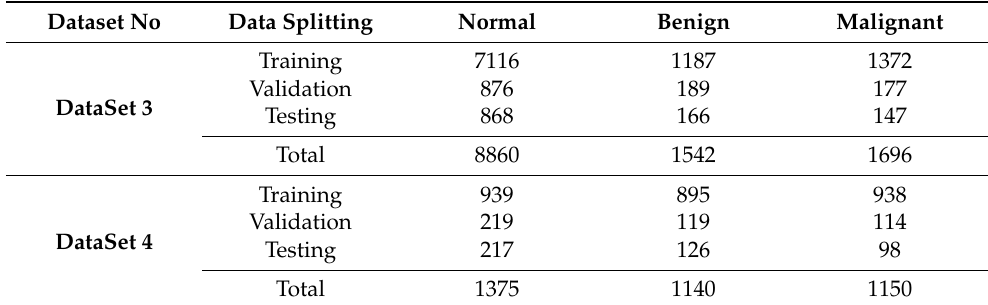
Table 5. Splitting based on the patient level to create (400 × 400, 512 × 512) patches using augmentation for normal, benign, and malignant cases.